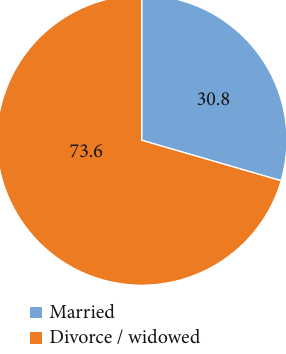
Figure 3: The ratio of marital status and care needs of the researcher.